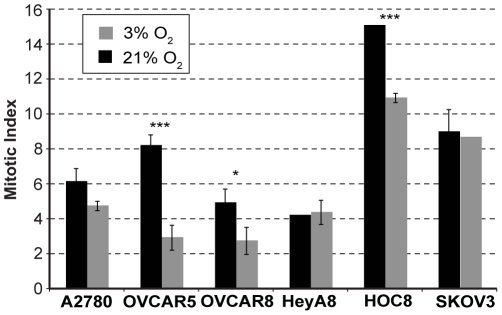
Mitotic index in the ovarian cancer cell lines grown under 3% or 21% O2.Mitotic index in the ovarian cancer cell lines that were cultured under 3% or 21% O2 for 3 days were determined by counting nuclei with condensed chromosomes, among the minimum of 1000 cells present in each experiment. Statistical significance was determined by ANOVA and the significant difference in the mitotic index between 3% and 21% O2 is denoted by an asterisk [(*) p<0.05, (***) p<0.0001].